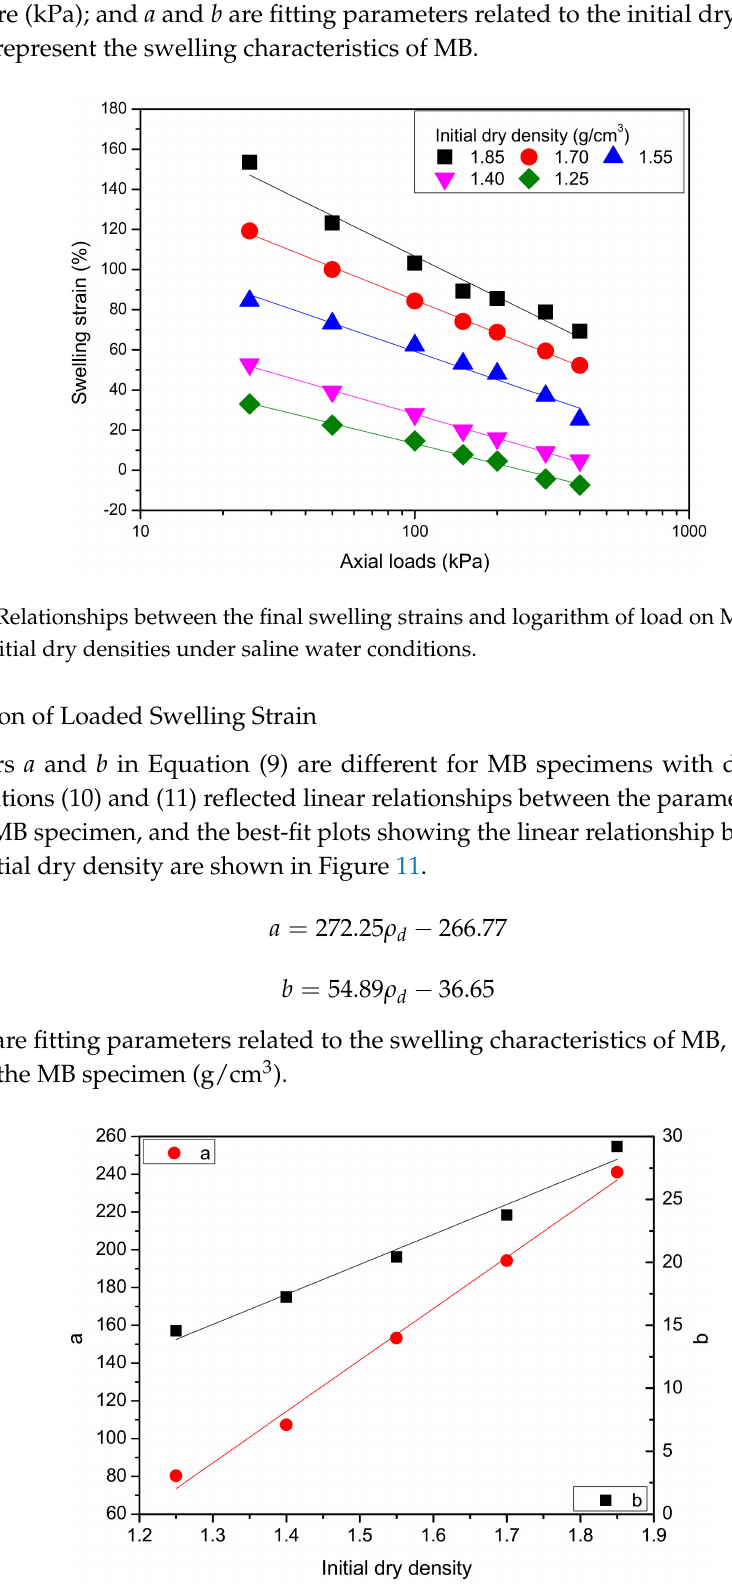
Figure 11. Fitting plots of relationship between a and b and initial dry density of MB